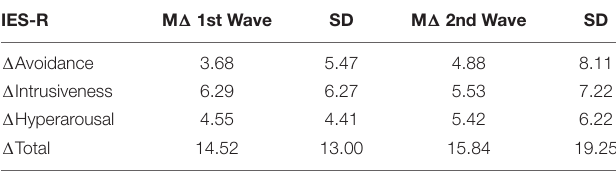
TABLE 3 | Delta of IES-R variables in the first and second waves.